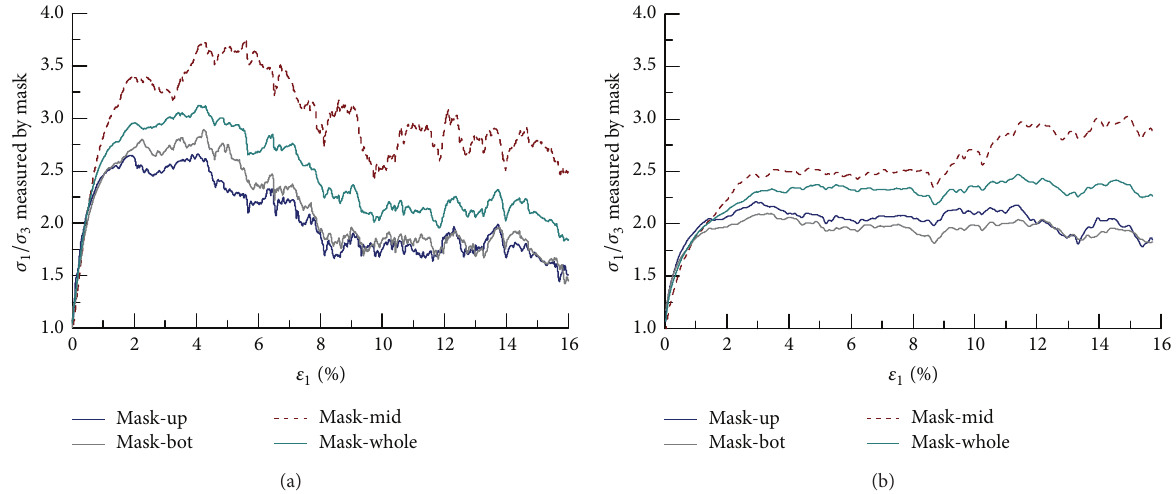
Figure 16: The evolution of stress ratio 𝜎 1 /𝜎 3 measured in different masks with axial strain 𝜀 1 under Flexible boundary: (a) 𝛿 = 0 ∘ and (b) 𝛿 = 90 ∘